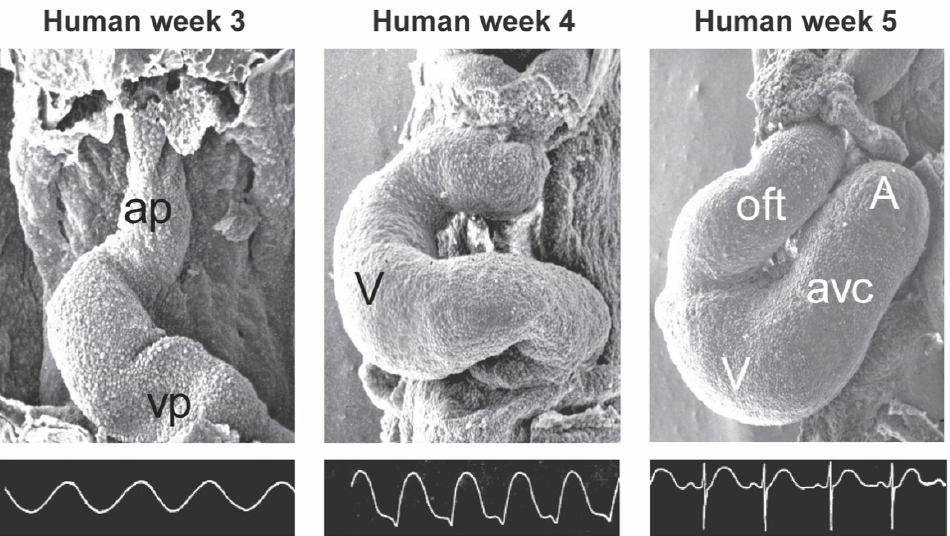
Figure 1. The electrocardiogram of the developing heart. The photographs are scanning electron microscope images of the developing chicken heart of the following stages: from left to right, Hamburger/Hamilton state 11, 14 and 18 correspond to 3, 4 and 5 weeks of human development, respectively. The electrocardiograms are recorded from different chickens of similar developmental stages to the corresponding photographs. These figures are courtesy of S. Virágh and G. Steding. Ap, arterial pole; vp, venous pole; V, ventricle; oft, outflow tract; avc, atrioventricular canal; A, atrium.